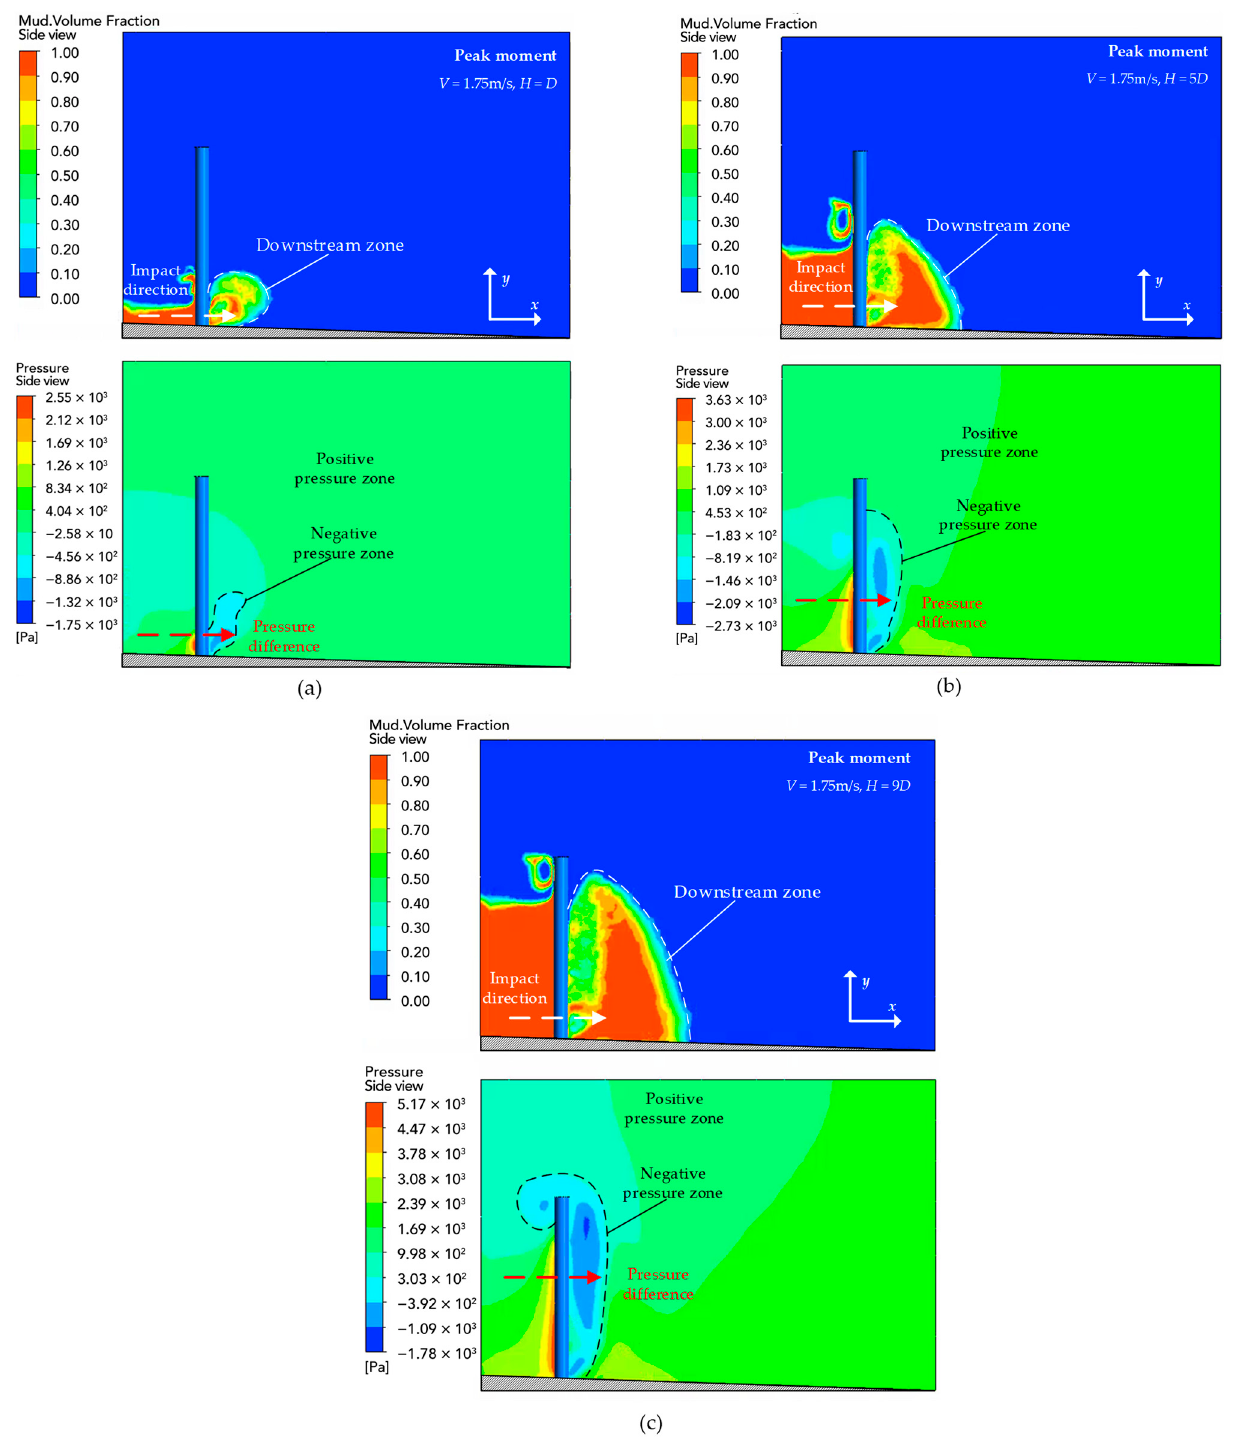
Figure 10. Volume fraction and pressure distribution diagram of submarine debris flow under different flow heights ( H ) conditions at the peak moment. ( a ) U ∞ = 1.75 m/s, H = D ; ( b ) U ∞ = 1.75 m/s, H = 5 D ; and ( c ) U ∞ = 1.75 m/s, H = 9 D .